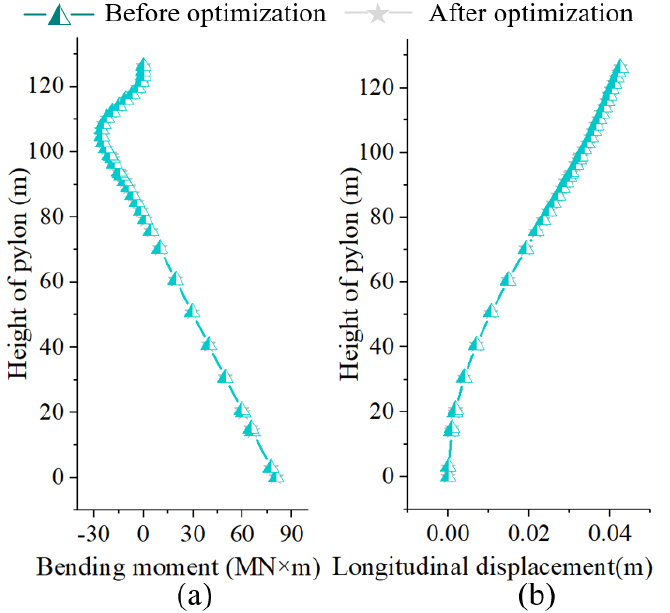
Figure 17. Mechanical performance of the concrete girder. ( a ) Vertical deviation. ( b ) Bending mo- ment .